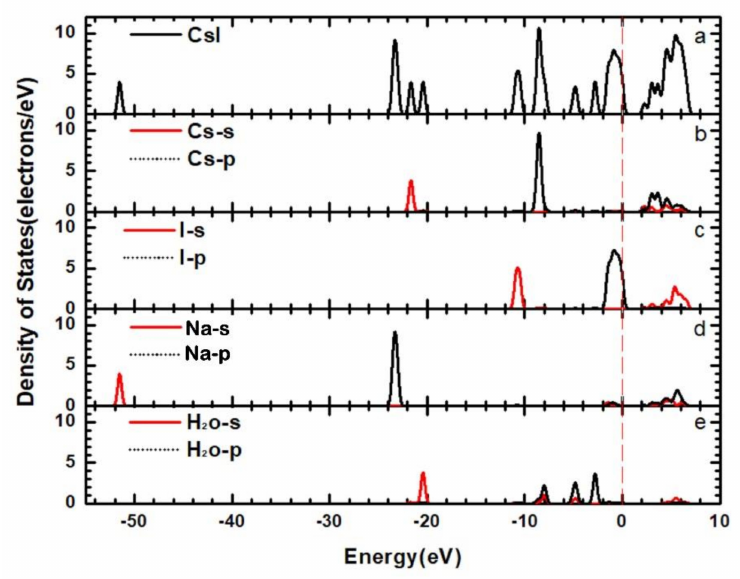
Figure 10. (Color online) TDOS ( a ) and PDOS ( b – e ) of the CsI(Na) (010) surface adsorbing H 2 O molecules.